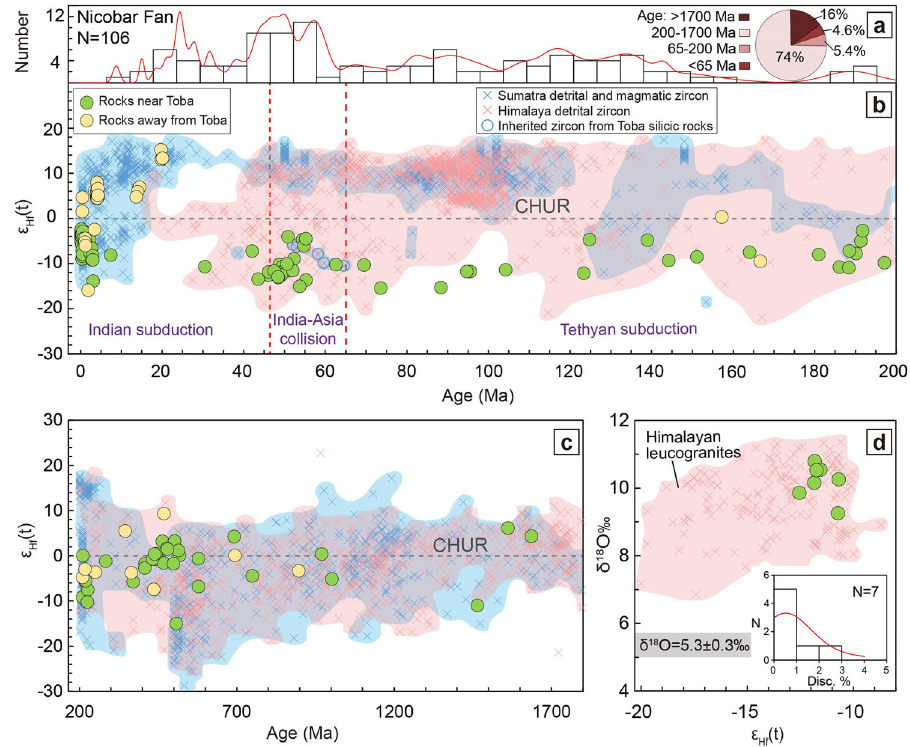
Fig. 6 Zircon U-Pb ages and Hf-O isotopic compositions of the studied rocks compared with those from the subducted Nicobar Fan sediments, Sumatra Island, and Himalayas. a Detrital zircon age spectra of the Nicobar Fan sediments (data from ref. 22 ). Inset is a pie graph showing the proportions of detrital zircons from the Nicobar Fan sediments with different age ranges. b Zircon ages (<200 Ma) versus ε Hf (t) values of the studied samples, also shown are ages versus ε Hf (t) values of detrital zircons from Himalayas 88 – 92 and detrital and magmatic zircons from Sumatra 28,32,93 . c Similar with b but for ages >200 Ma. d δ 18 O versus ε Hf (t) values of inherited zircons with ages varying between 30 and 55 Ma from rocks near Toba. Pink crosses represent ε δ 18 O values of contemporary zircons from Himalaya leucogranites 46 . The insert shows the U-Pb age discordance for zircons used in d . CHUR- Hf (t) and Chondritic Uniform Reservoir.